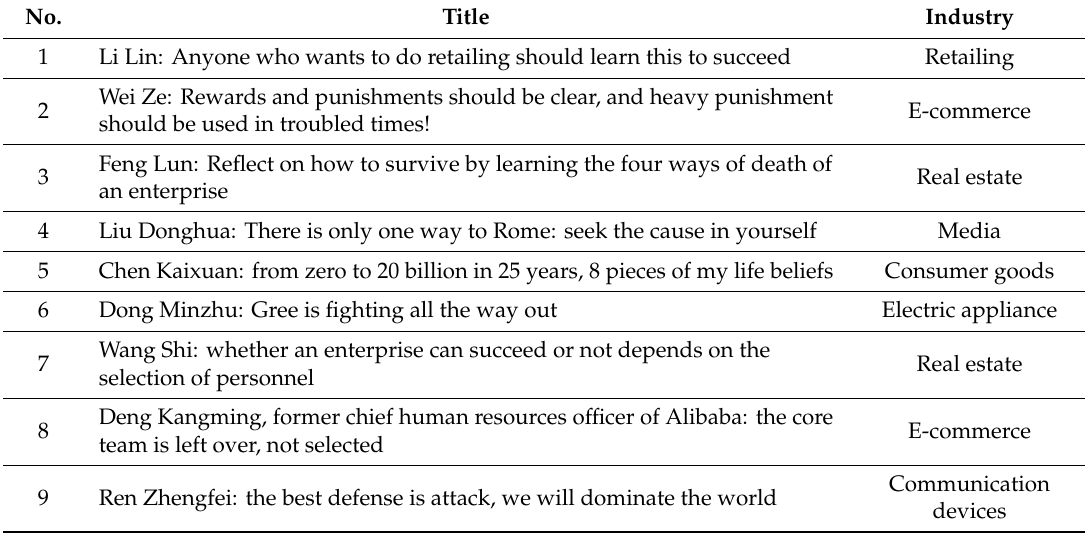
Table A1. The title and relative industry of the selected